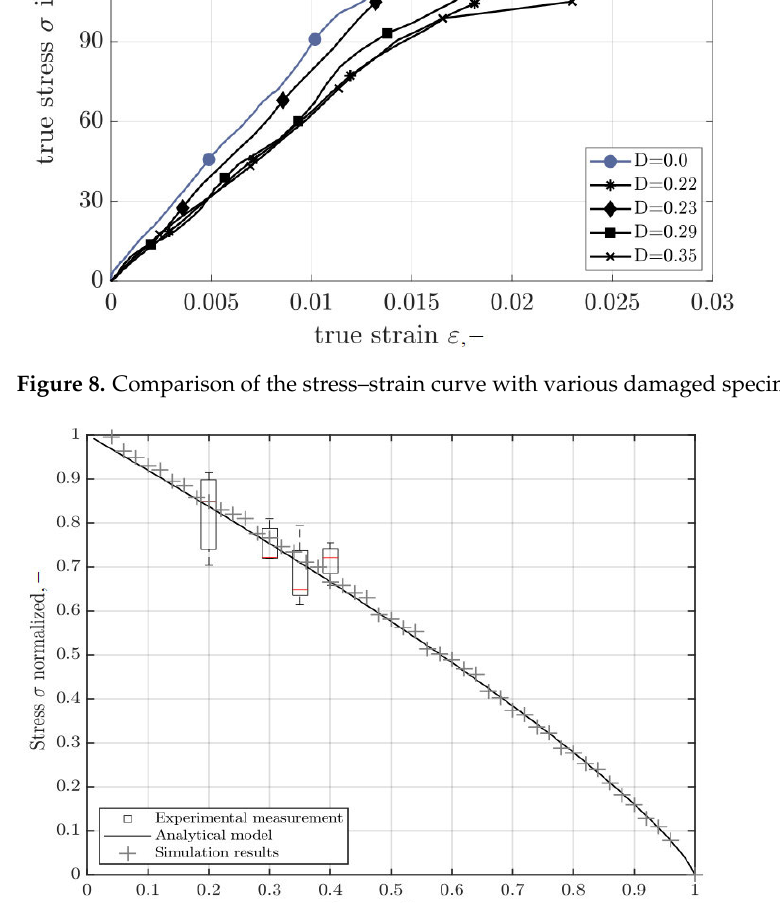
Figure 9. Comparison between the analytical model and the simulation implementation of the weakened material